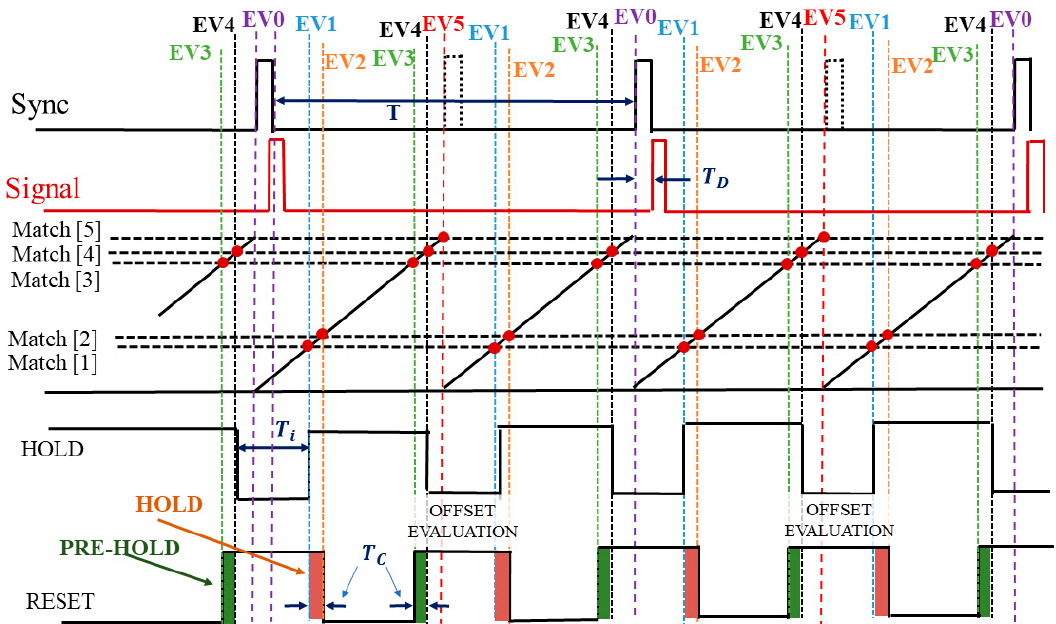
Figure 5. Time diagram of SCT control signals for HOLD and RESET switches synchronized with sync pulses. Red dots represent a match (1..5) condition for timer counter generating a corresponding event (EV1..5).